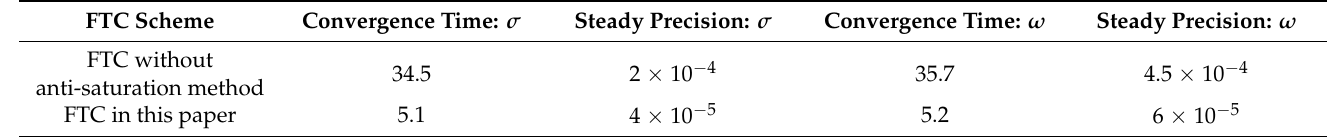
Table 5. Comparative analysis of performance with proposed FTC without anti-saturation